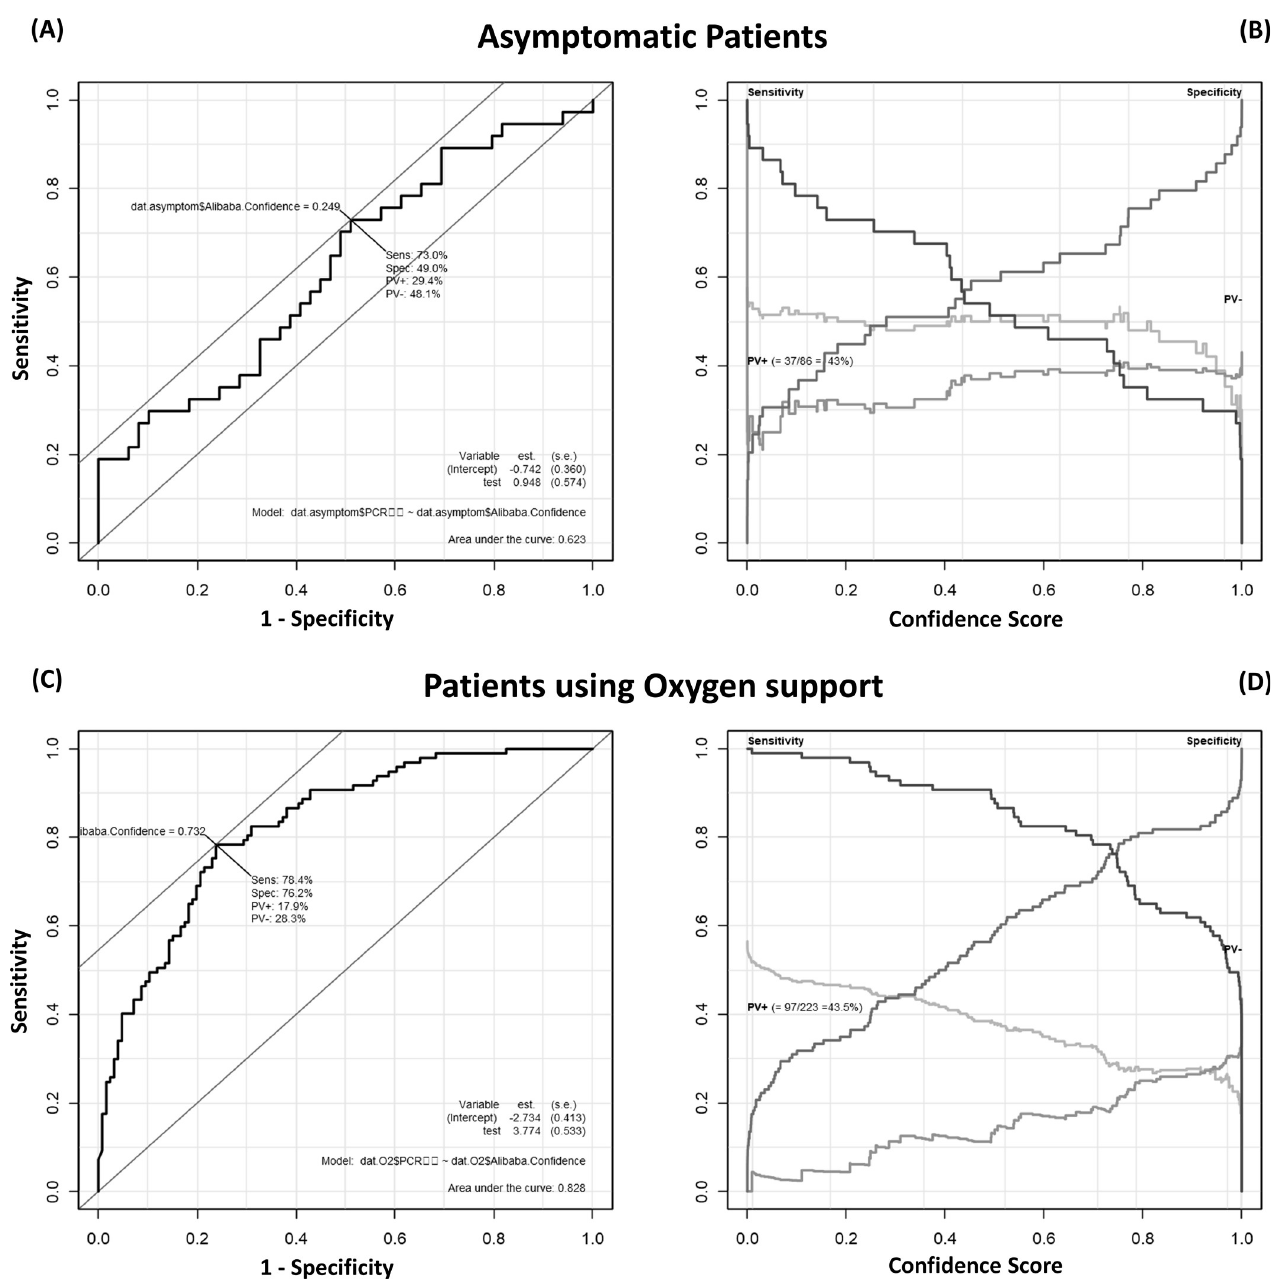
Fig 4. Receiver operating characteristic (ROC) curves when ignoring imperfect reference and considering imperfect reference. (A) A plot of test sensitivity (y-coordinate) versus its false-positive rate (x-coordinate) obtained at each cut-off level of confidence score ignoring imperfect reference. The area under the ROC curve is 0.797. (B) A plot of test sensitivity (y-coordinate) versus its false-positive rate (x-coordinate) was obtained at each cut-off level confidence score considering imperfect reference. The area under the ROC curve is 0.865.